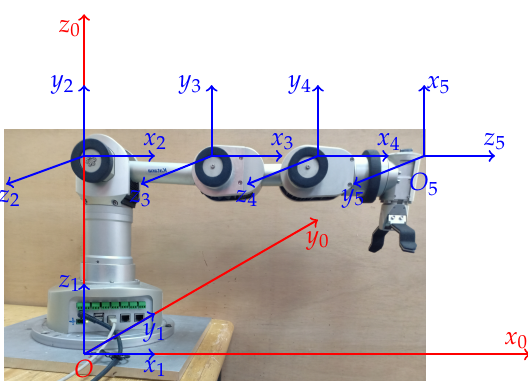
Figure 1. Configuration of the robotic arm, where x 0 , y 0 and z 0 are axes of the reference